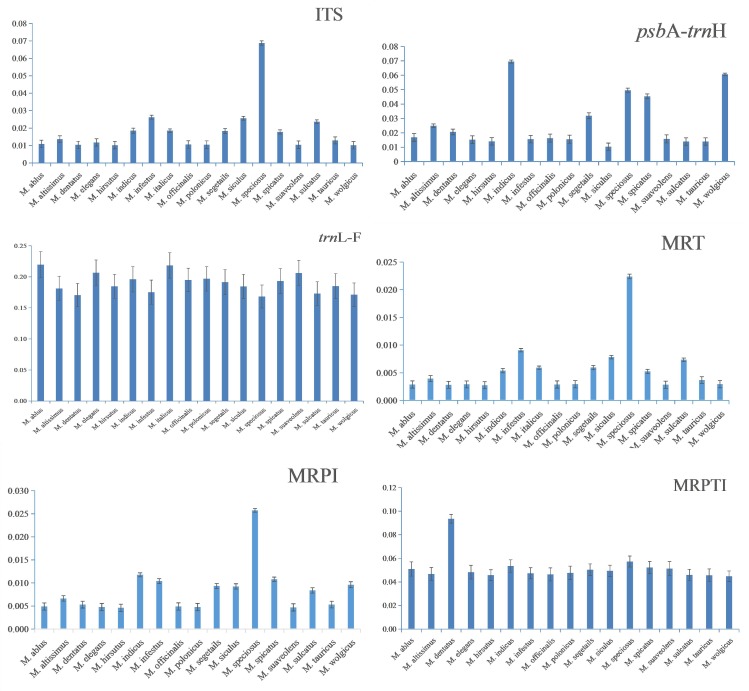
Average interspecific gene gap value for single and combined regions based on the analysis of hundreds of sequences by pairwise sequence alignment.